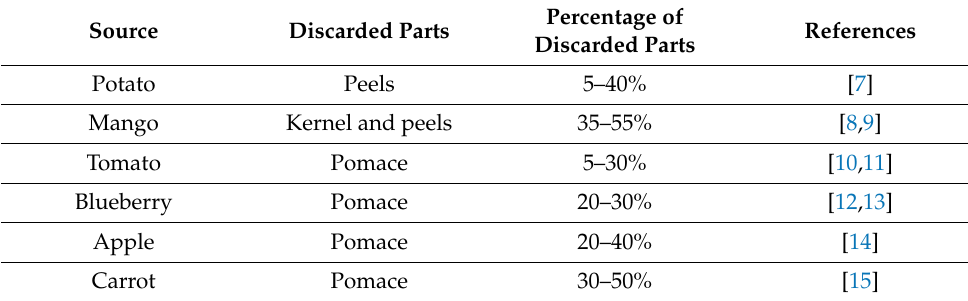
Table 1. Percentage of discarded parts in food